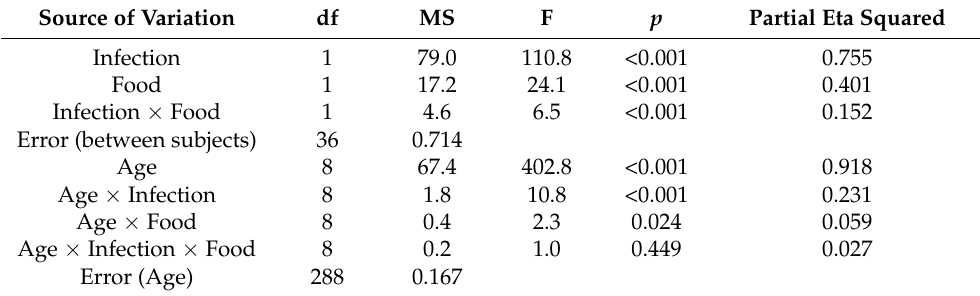
Table 1. Repeated measures analysis of variance on the effect of infection (first factor), food (second factor), and age (repeated factor) on Ceratitis capitata male sexual signaling. Ages from adult day 1 to adult day 15 were considered in the analysis.